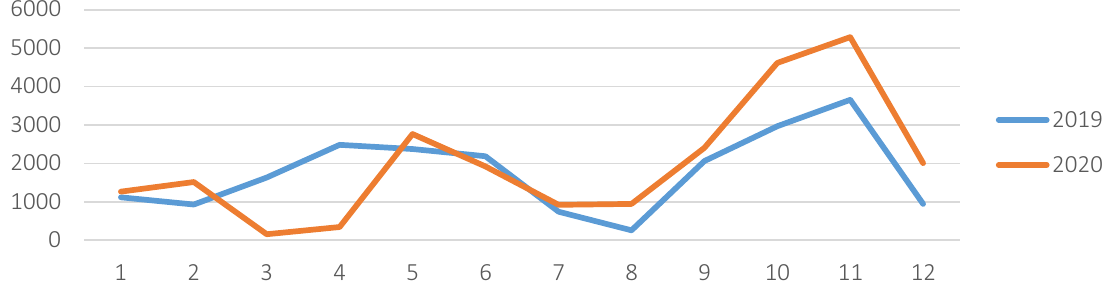
Figure 5. Monthly number of participants in brokerage events in 2019 and 2020 according to the EEN event